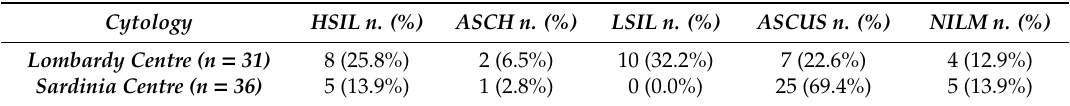
Table 1. Pap test results of the human papillomavirus (HPV)16-positive women enrolled. High-grade squamous intraepithelial lesion (HSIL), atypical squamous cells—cannot exclude HSIL (ASCH), low-grade squamous intraepithelial lesion (LSIL), atypical squamous cells of undetermined significance (ASCUS), and negative for intraepithelial lesion or malignancy (NILM). Cytology HSIL n. (%) ASCH n. (%)